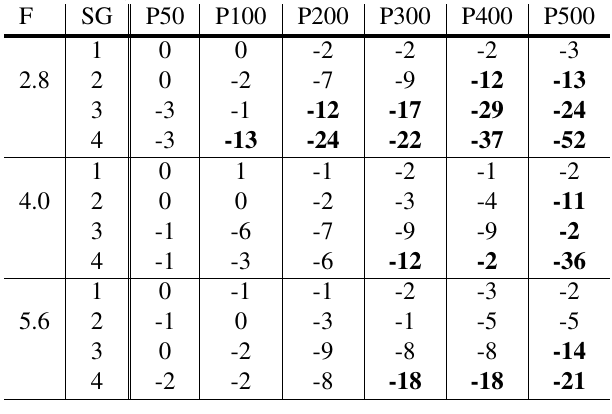
Figure 8 . Results on all data sets without dust simulation. The detection rate is shown with regard to the Euclidean dis- tance error in pixels. The vertical red line shows the track- ing rate at a 5 pixel error, the tolerance where all algorithms have reached saturation and that we will use throughout the following evaluation. Performance of the SET algorithm. The results show the re- duction in detection rate (in %) due to dirt for an error rate of 5 pixels. The baseline are detection rates achieved on clean images. F represents the focal length, SG the size group, whereas P50-P500 values specify the amount of particles. Bold highlights a reduction in the detection rate relatively to clean data of more than